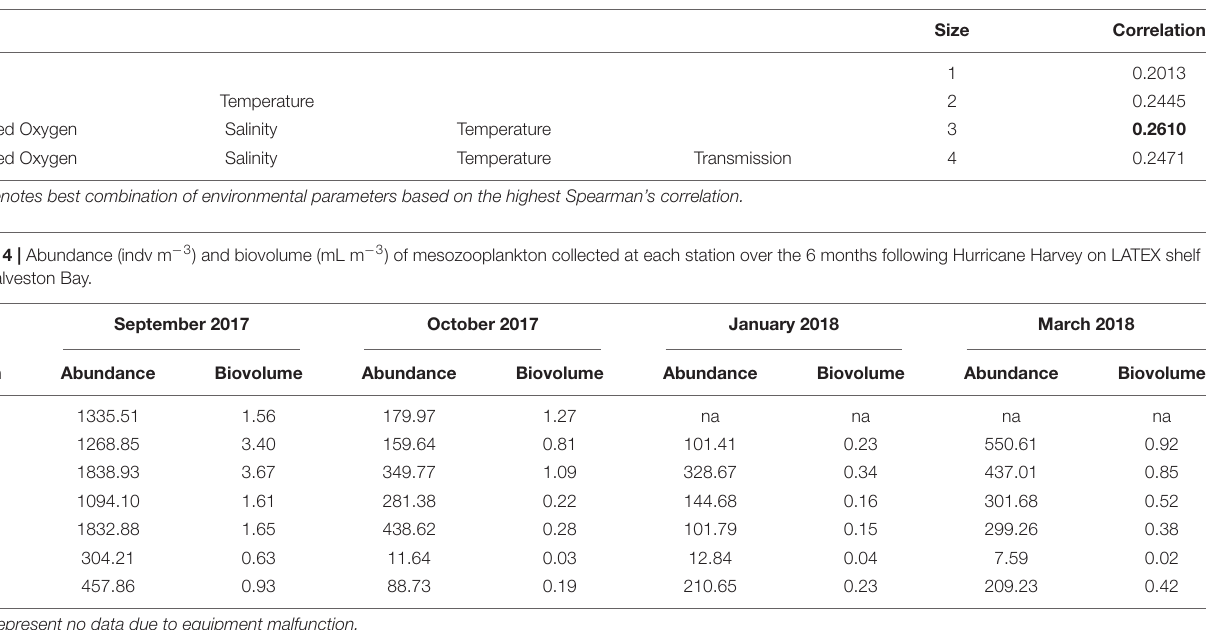
FIGURE 4 | Results of SIMPER analysis between cruises. Top five highest contributing taxa to structural differences were chosen to explain over 50% of the variance. TABLE 3 | Results from BIOENV